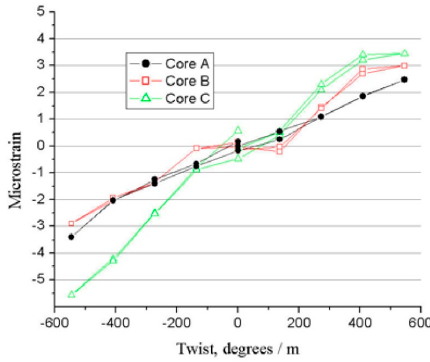
Figure 19. Twist-to-strain response of MCF-FBGs in one rosette [145].